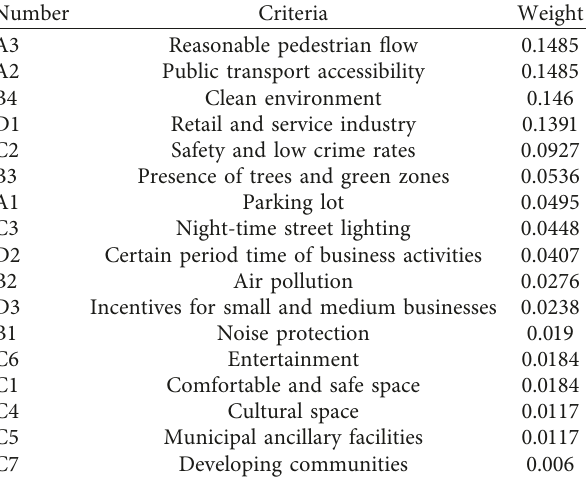
Table 7: Comparison of criteria